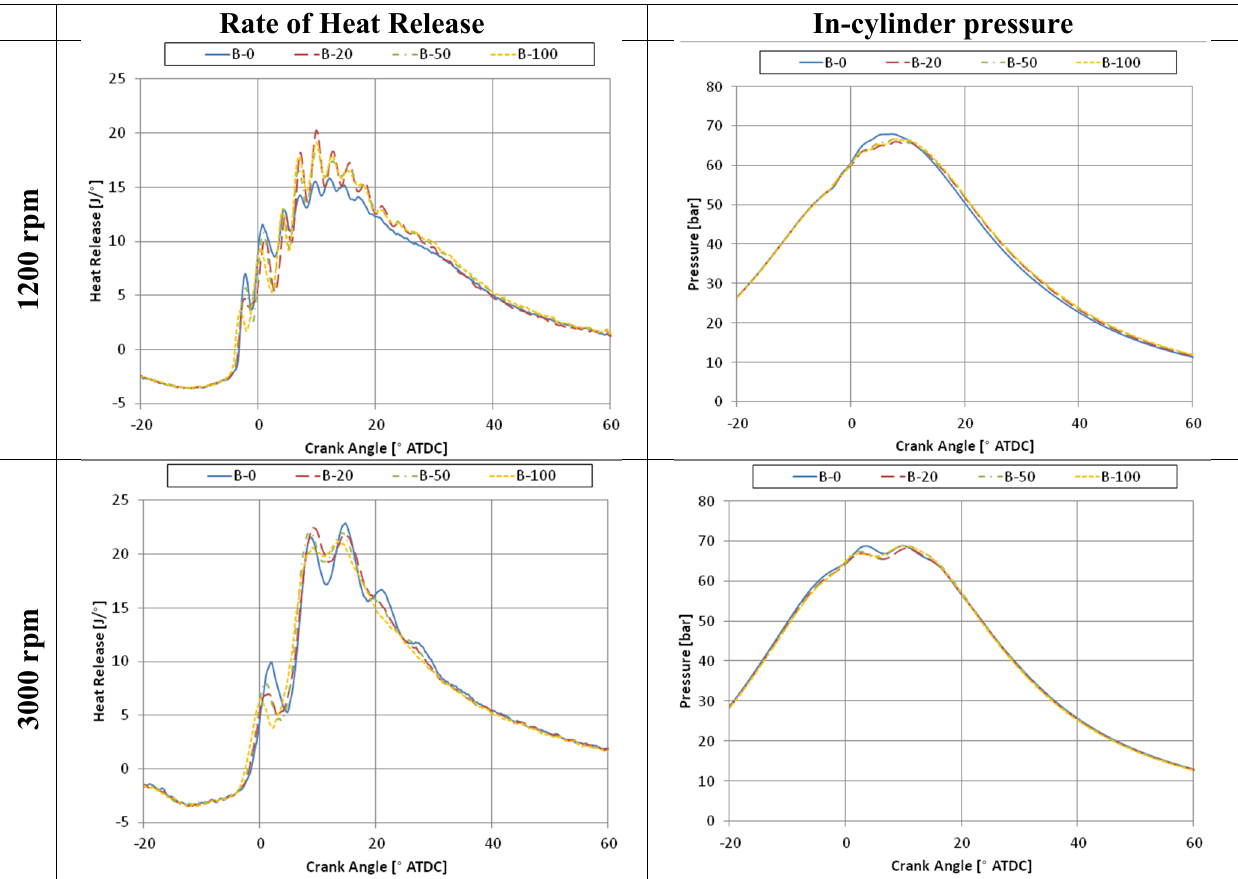
Figure 4. Combustion heat release and in-cylinder pressure as a function of crank angle for different engine rotational